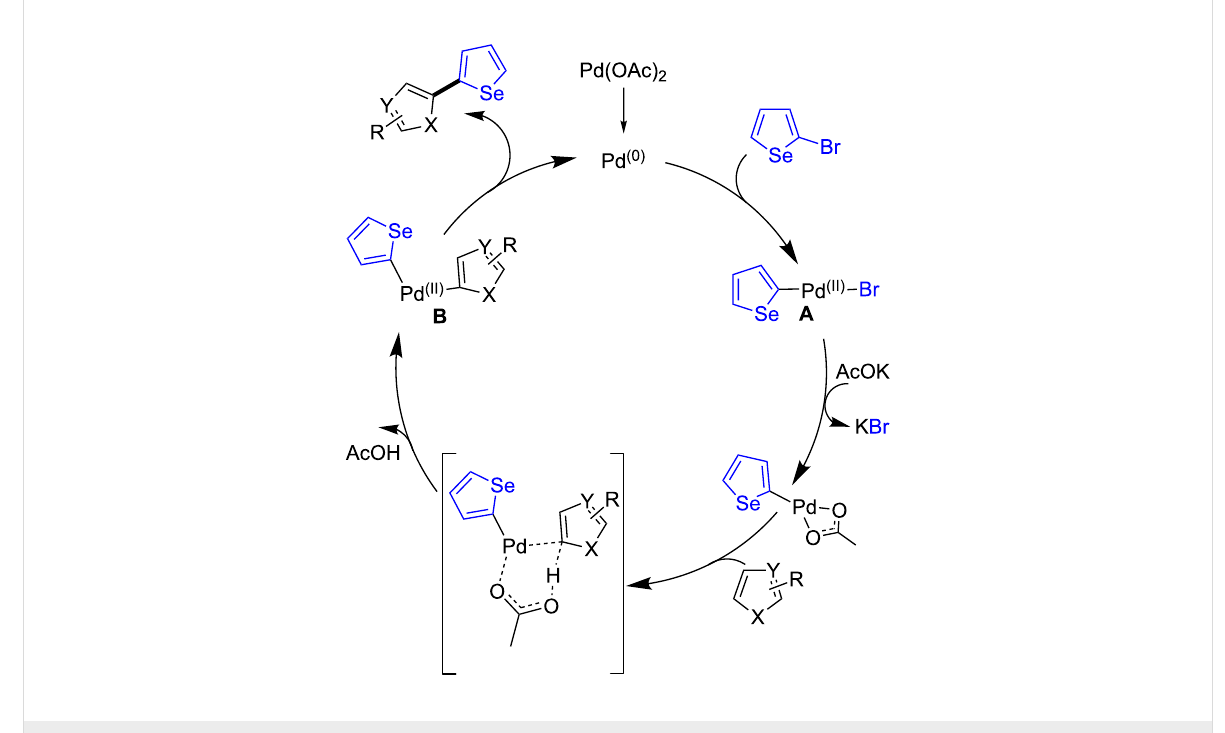
Scheme 5: Proposed catalytic